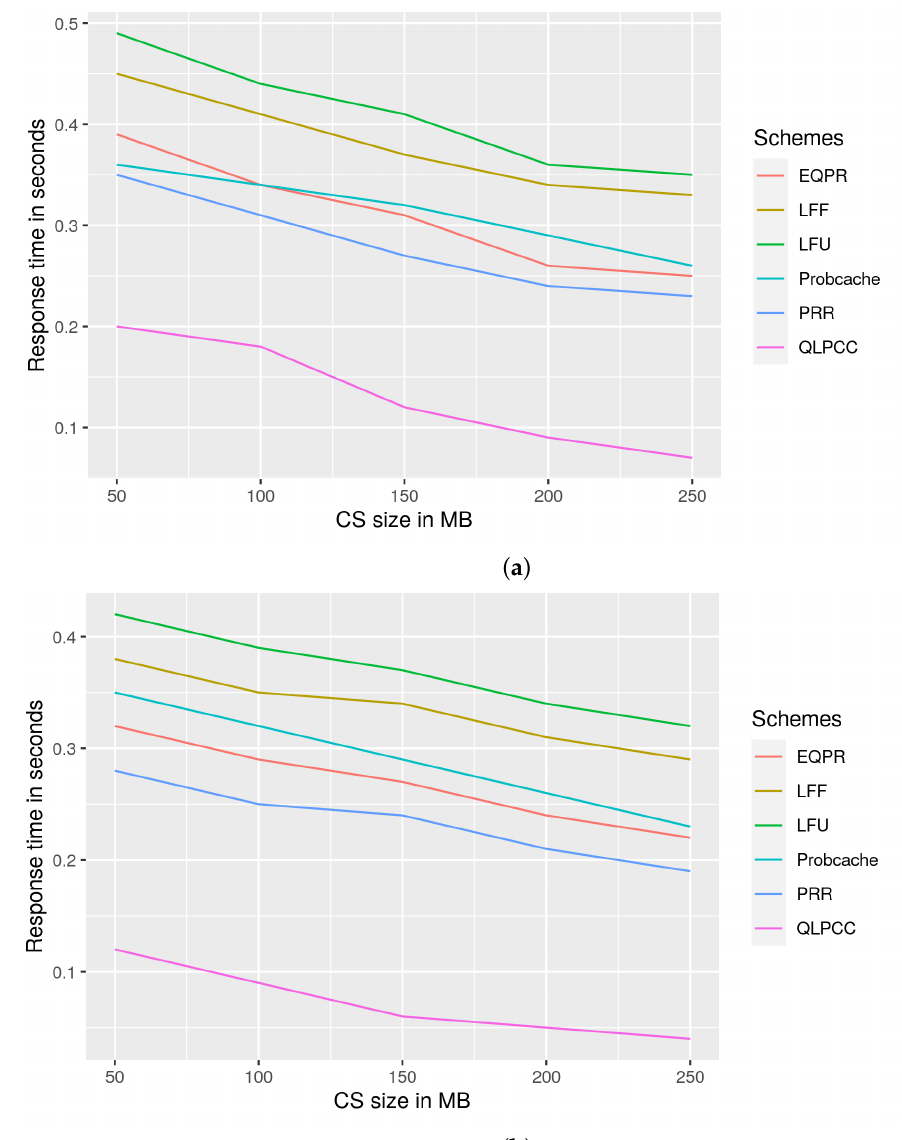
Figure 8. Response time vs. QoS-node content store size for overall traffic. ( a ) Response time vs. QoS-node content store size (overall traffic) for | M | = 500. ( b ) Response time vs. QoS-node content store size (overall traffic) for | M | =